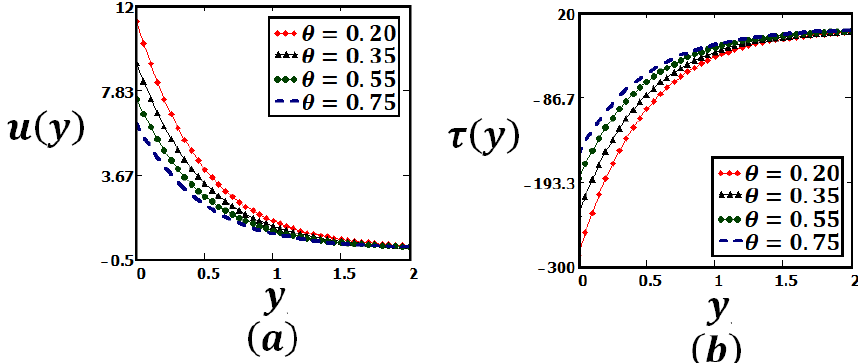
Figure 9: Profiles of the velocity field u ( y , t ) and the shear stress τ ( y , t ) for fractionalized Jeffrey fluid given by Eqs. (16) and (21), for A = 1, ν = 1.427, µ = 19, λ 1 = 3, λ 2 = 2, H = 0.5, K = 2, α = 0.5, p = 4, t = 2 s and different values of θ